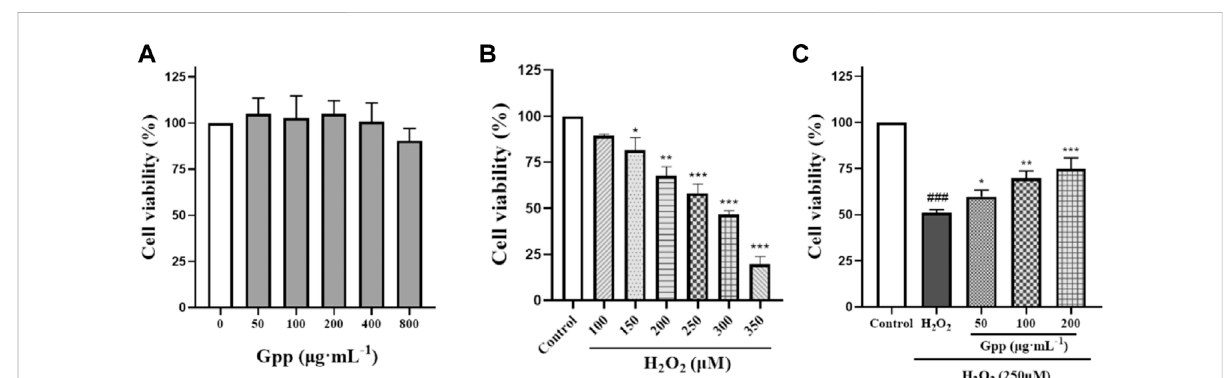
Effect of different concentrations of GPP pretreatment on PC12 cell survival (A) Effect of different concentrations of H 2 O 2 treatment on PC12 cell survival (B) Protective effect of different concentrations of GPP pretreatment on H 2 O 2 250 μ M induced PC12 damage (C) . * p < 0.05, ** p